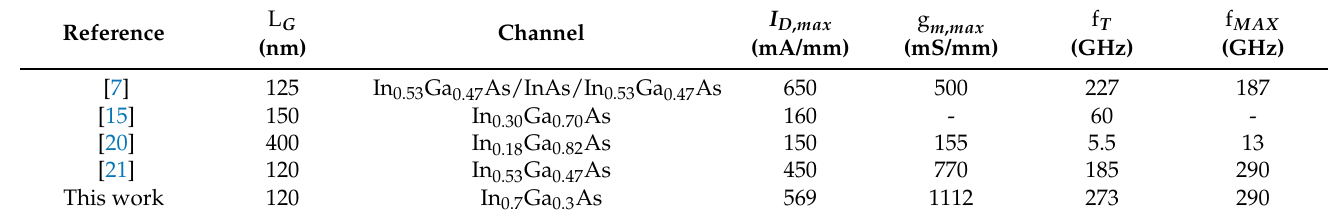
Table 2. Comparison with published InGaAs channel transistors on Si